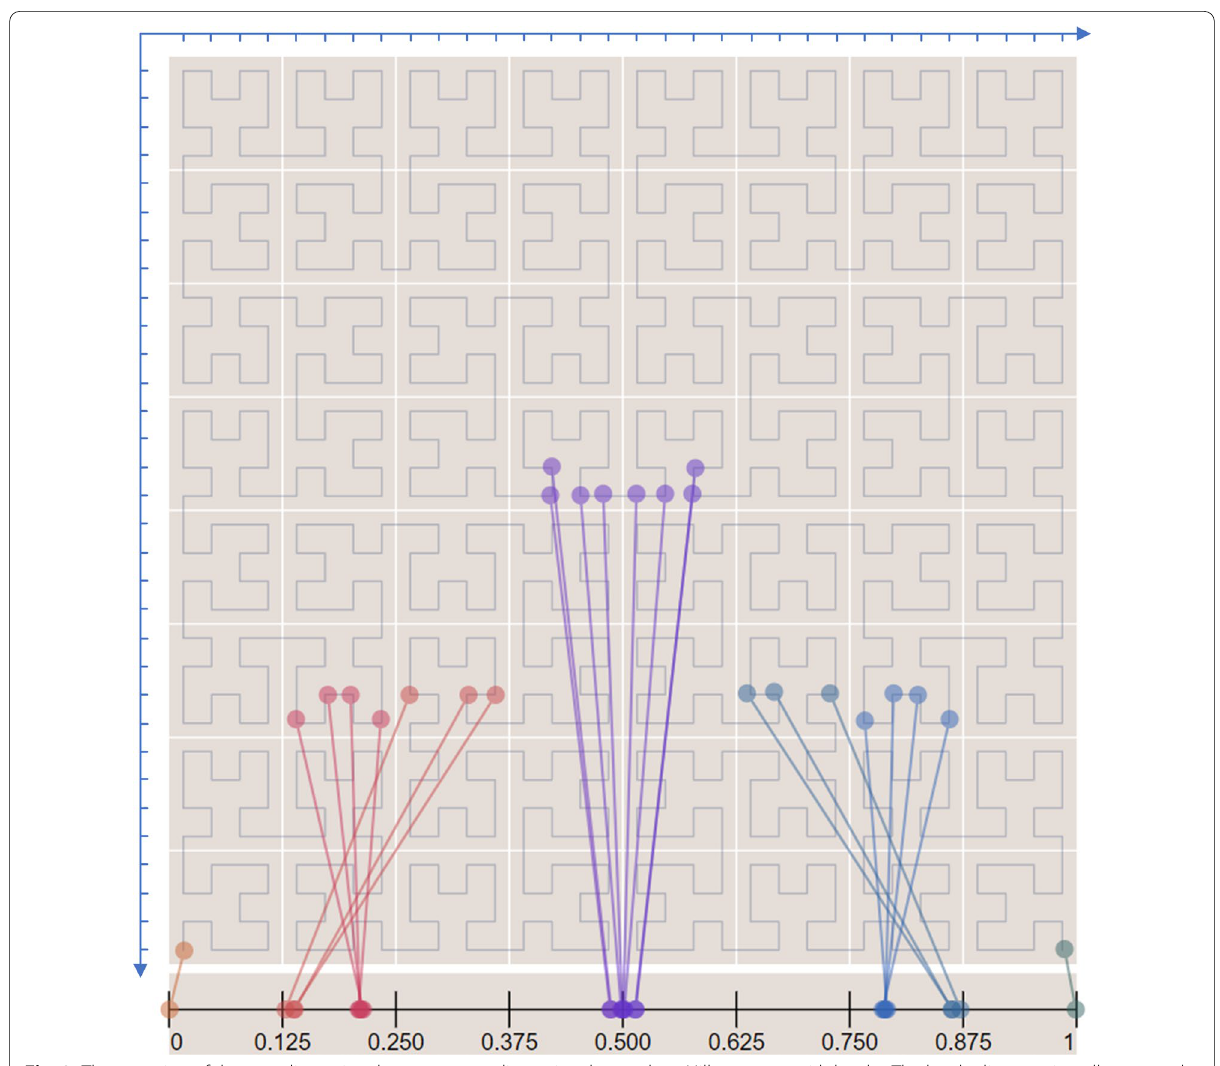
Fig. 2 The mapping of the two-dimensional space to one-dimensional space by a Hilbert curve with level 5. The local adjacency is well preserved by mapping the points in the two-dimensional space to the one-dimensional space. The platform is obtained from http:// bit- player.